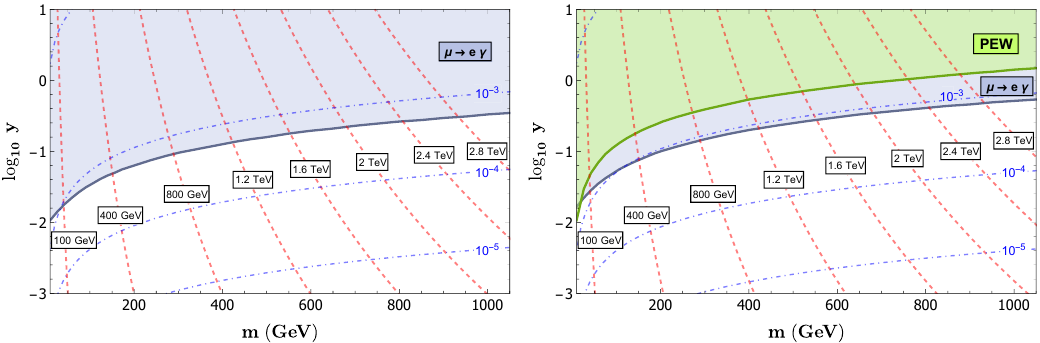
Figure 4 . Constraints on the parameter space of the uniform clockwork model from (cid:22) precision electroweak (cid:12)ts. Left panel: normal (hierarchical) spectrum of active neutrinos. Right panel: degenerate spectrum of active neutrinos. Dashed/red lines indicate the mass of the lightest clockwork neutrino, while dot-dash/blue lines indicate the coupling of this state to the SM gauge